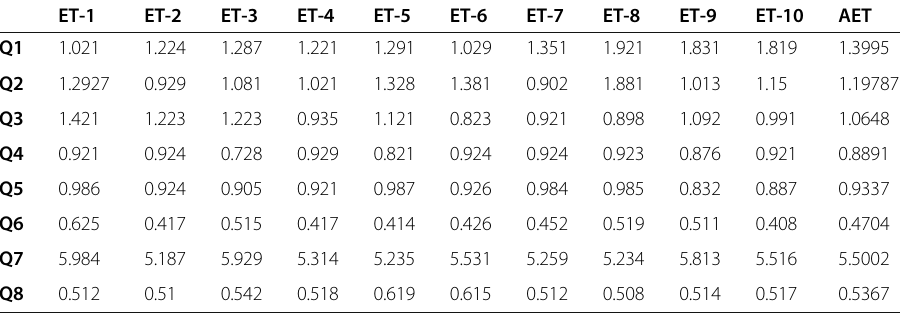
Table 17 Query execution time for custom Kubernetes cluster on Washington State for HC-2